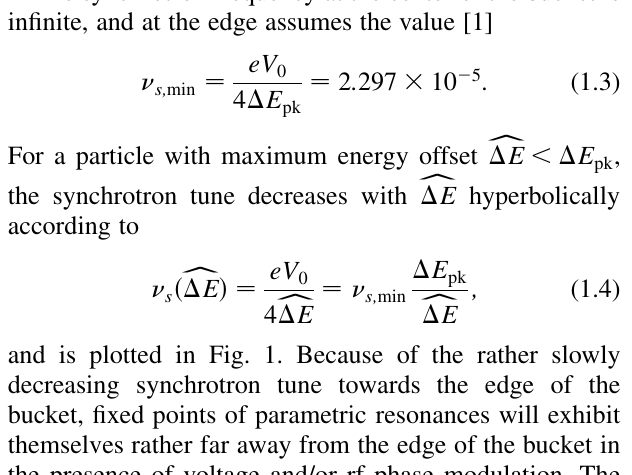
(cid:1) 1 : 27 (cid:1) s , 1